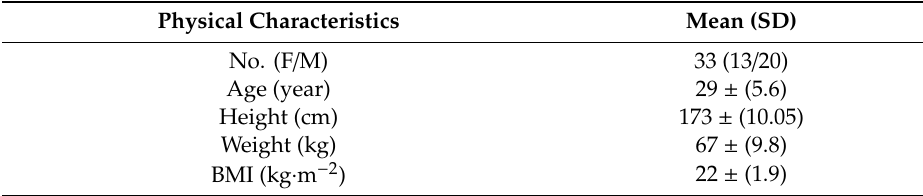
Table 2. Physical characteristics of the participants involved in the